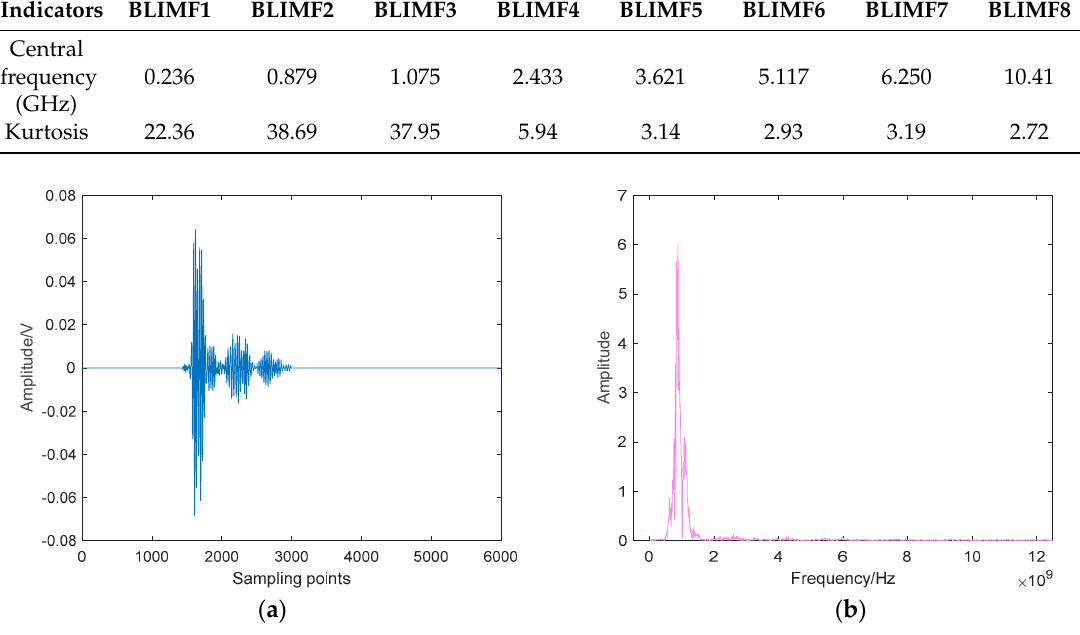
Figure 19. Final denoising result by AVMDSSA: ( a ) Time-domain waveform; ( b ) Spectrum.